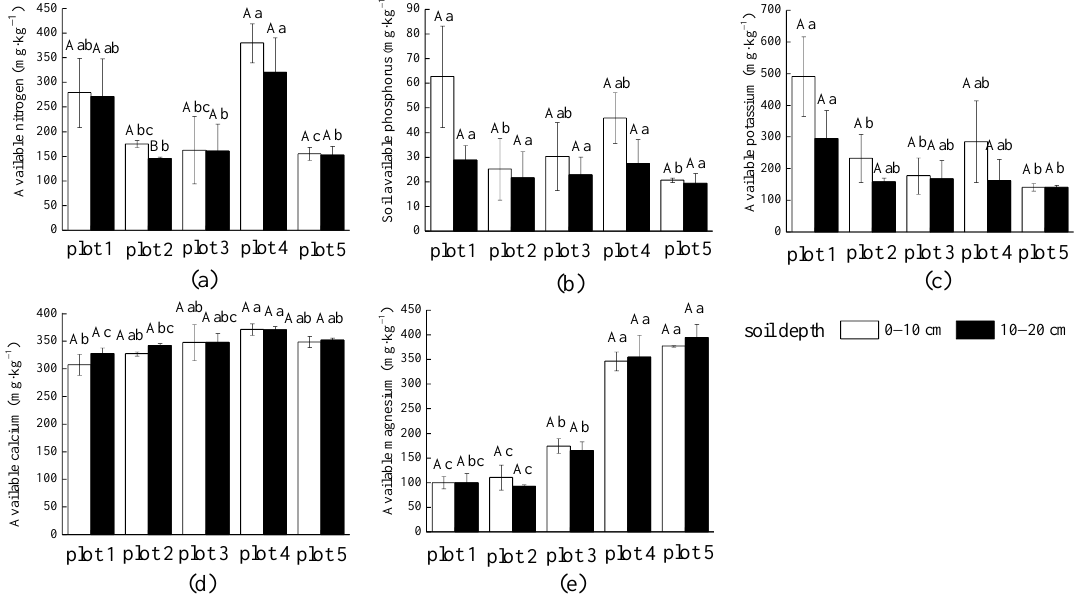
Figure 2. Soil available nitrogen ( a ), available phosphorus ( b ), available potassium ( c ), available calcium ( d ), available magnesium ( e ) of Z. planispinum plantations with different planting combinations. Plot 1, Z. planispinum + P. salicina ; plot 2, Z. planispinum + S. tonkinensis ; plot 3, Z. planispinum + A. hypogaea ; plot 4, Z. planispinum + L. japonica ; plot 5, Z. planispinum monoculture plantation. The vertical line on each bar is the error line, that is, the error range of the statistical results. The upper part is a positive error, and the lower part is a negative error. Lower case letters indicate significant differences between different plantation types of the same depth at p < 0.05; upper case letters indi- cate significant differences between different depths of the same plantation types at p < 0.05. One- way ANOVA was used to calculate the differences, p = 0.05, n = 15.